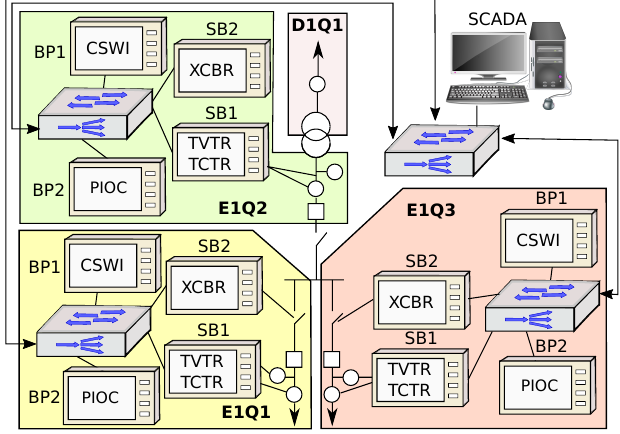
Figure 3. Diagram of the T1-1 substation